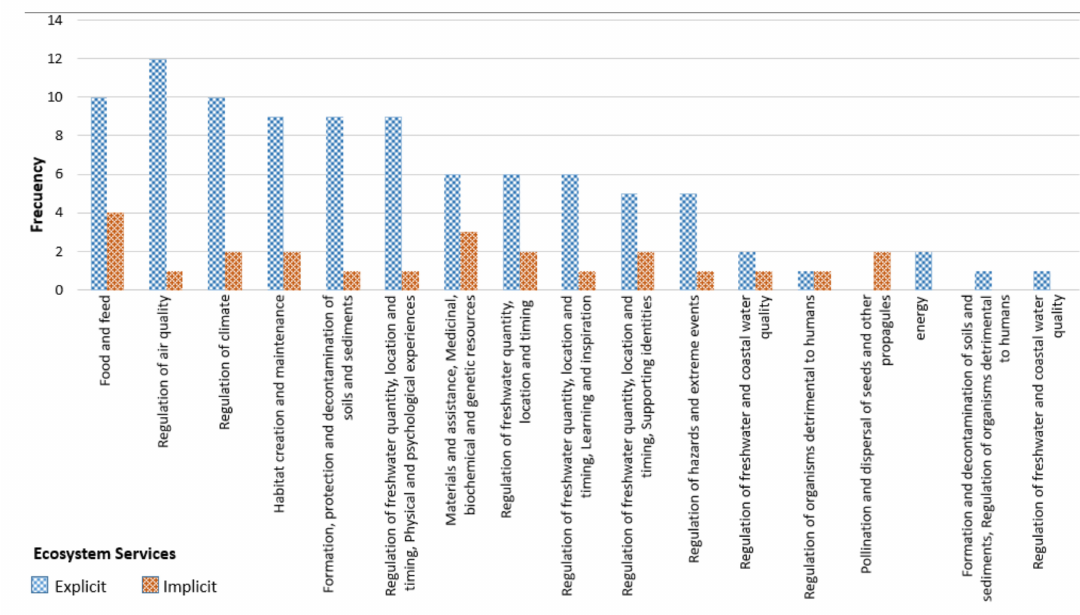
Figure 4. Explicit and implicit consideration of ecosystem services identified in the